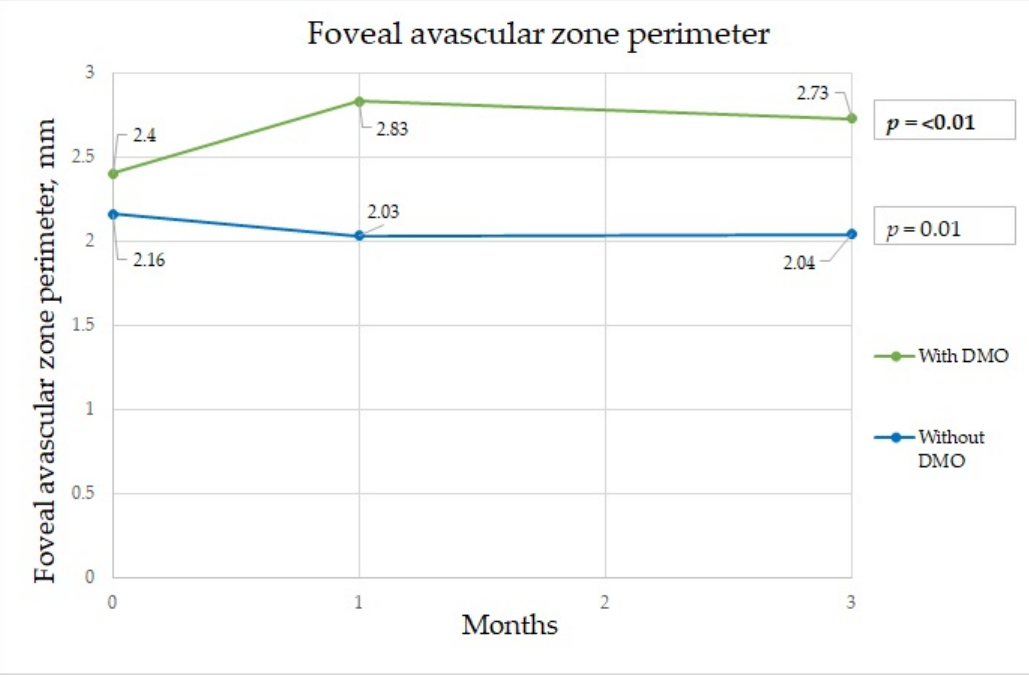
Figure 2. Foveal avascular zone perimeter changes during three-month period.